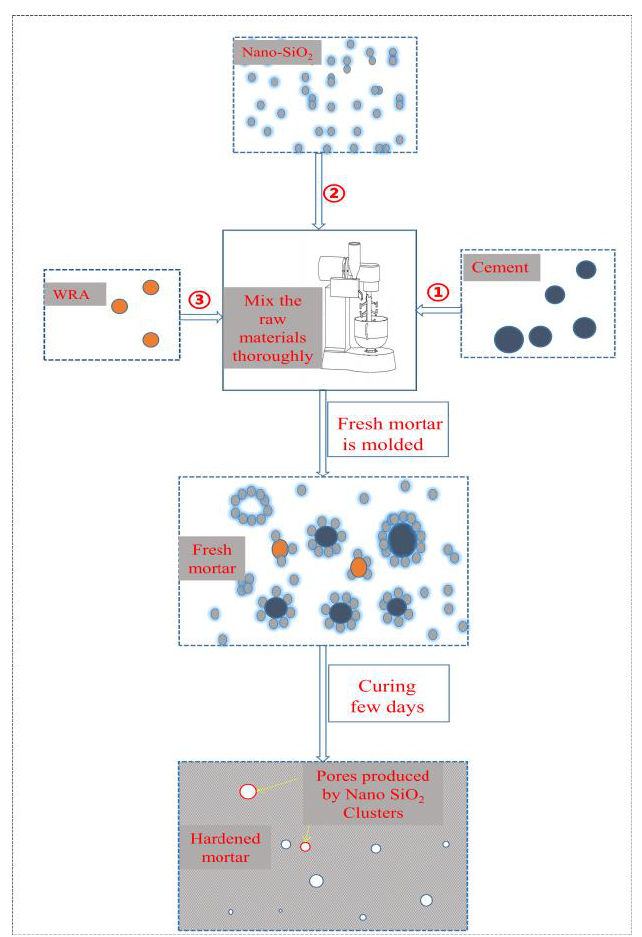
Figure 1. Experimental procedure diagram.